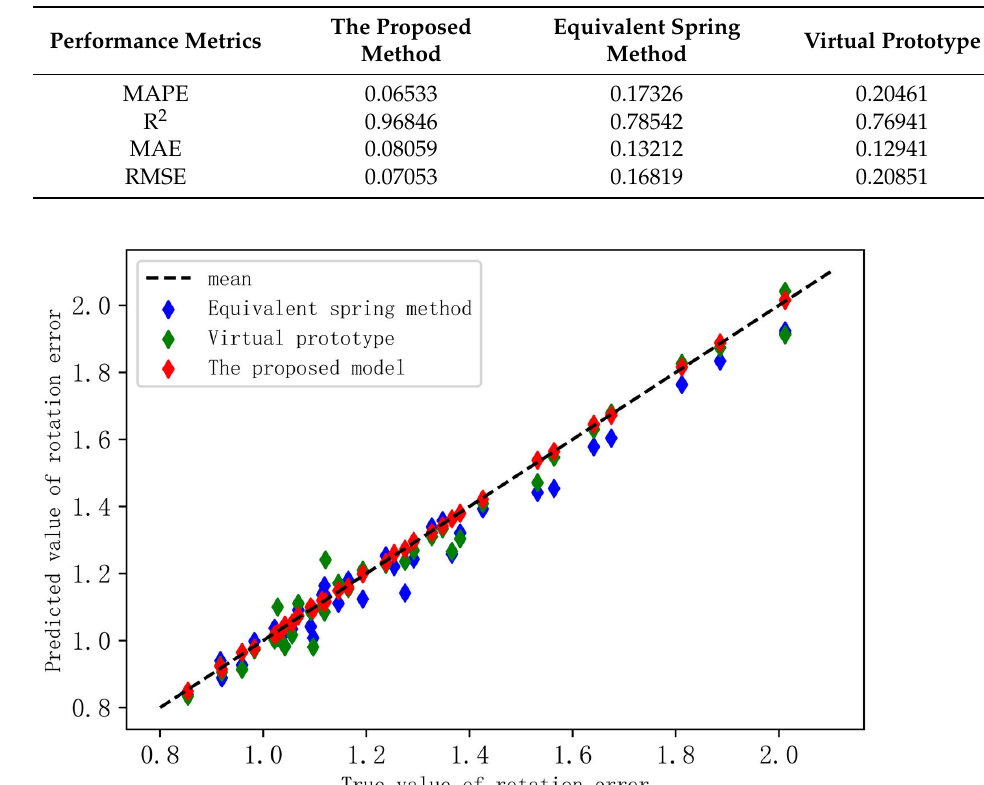
Figure 8. Test results of this model and two other models. Table 6. Comparison of regression accuracy of three models.